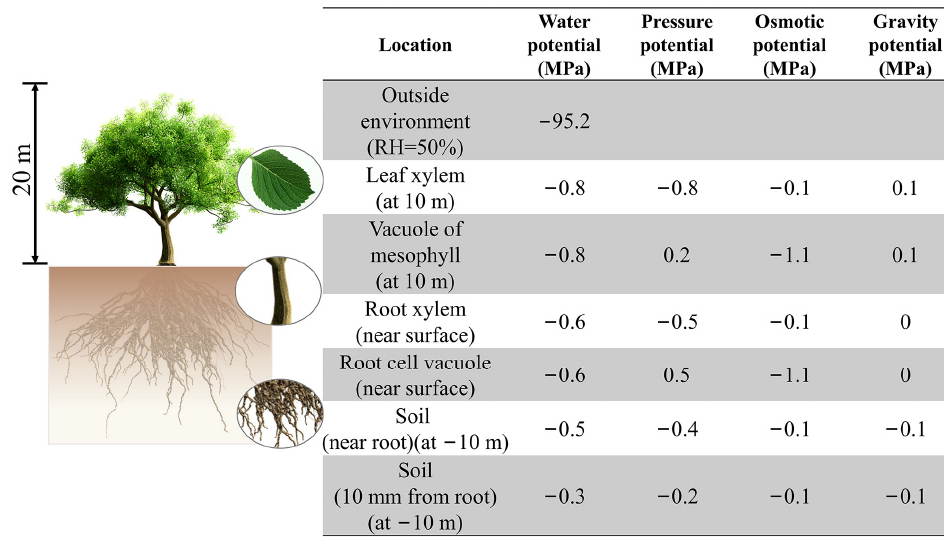
Figure 1. Schematic diagram of typical water potential at different locations during water transfer from soil to the atmosphere, modified from Taiz et al. [40].